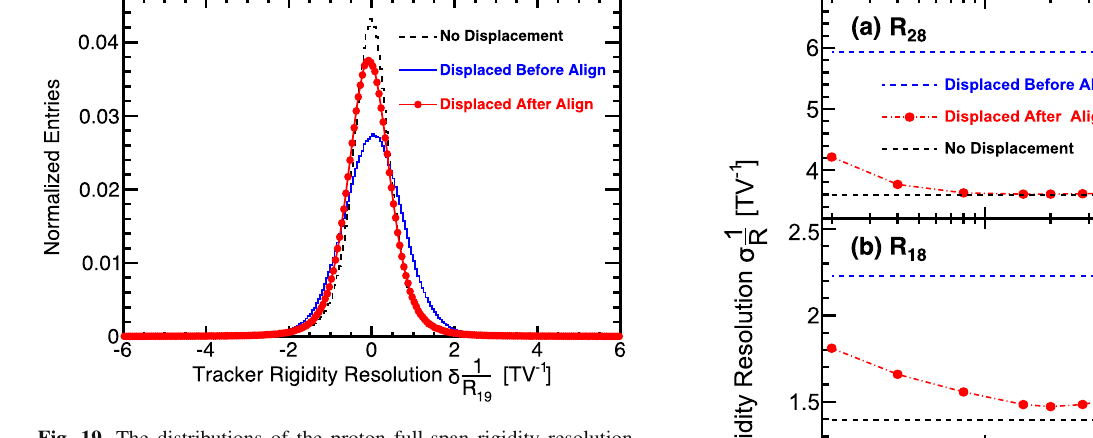
Fig. 19 The distributions of the proton full-span rigidity resolution (δ R − 1 ) at 1.5 TV for the MC samples with no tracker module displace- 19 ment (dashed histogram), displaced modules before alignment (solid histogram), and displaced modules after alignment using (cid:23) σ = 200 µ m (full circle histogram)